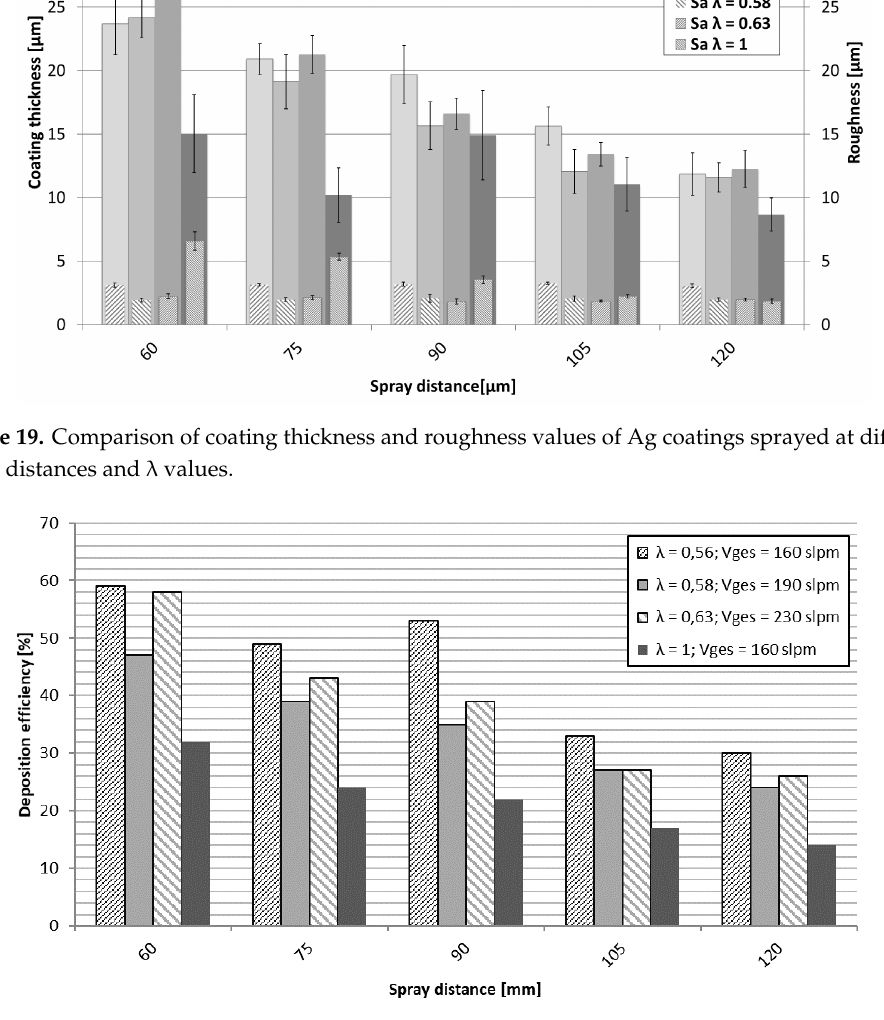
Figure 20. Deposition efficiency of Ag coatings for various spray parameter sets. Different spray distances for given sets of λ and total gas volume (slpm).